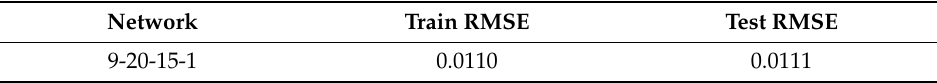
Figure 6. Error curves of learning % of inhibition on the training and the test set. Root mean square error ( rmse ) is employed to evaluate the performance and the network is trained for 10,000 epochs or until the rmse reaches 0.01, whichever occurs first. (The x -axis is plotted in log scale.) Table 4. Performance of the final 9-20-15-1 network on the train and test dataset. Network Train